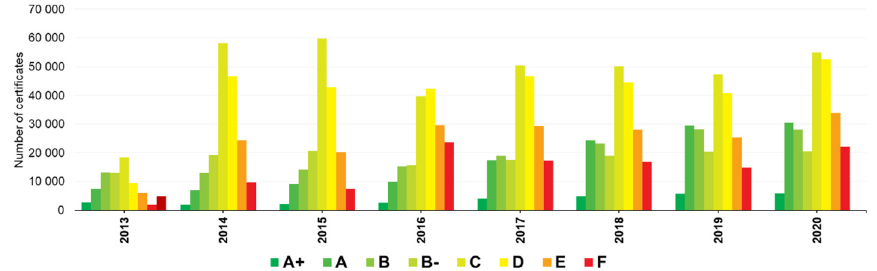
Figure 4. Energy performance certi fi cates by energy class issued in Portugal during 2008–2020. The